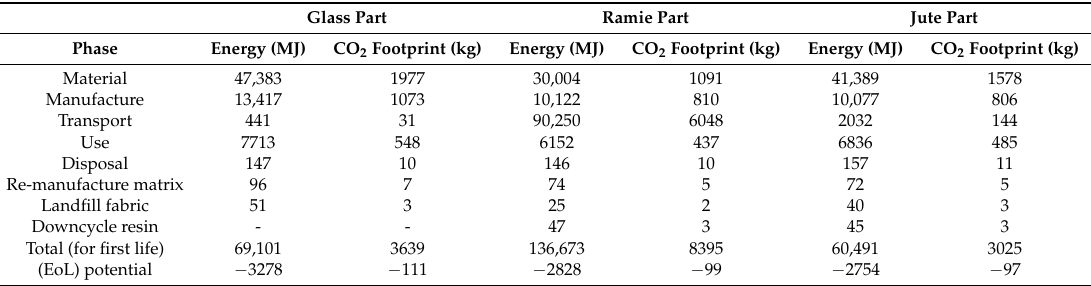
Table 13. Eco-Audit report of the energy and CO 2 footprint for all hood